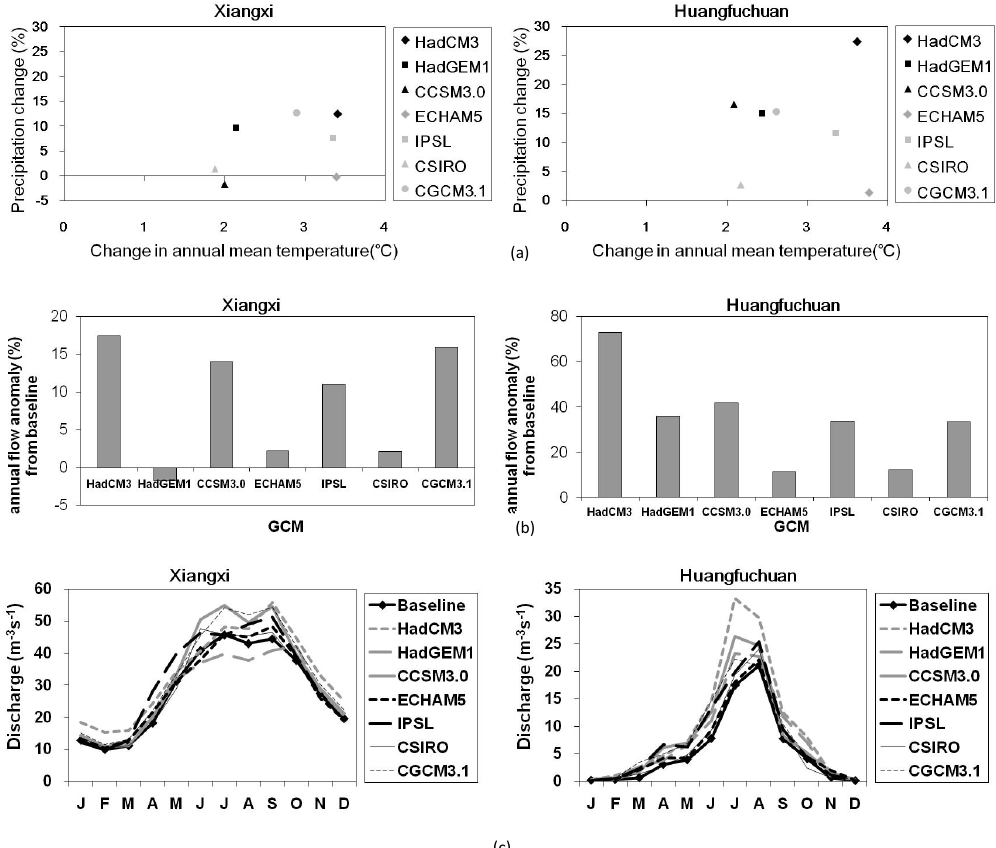
Fig. 5. (a) Projected changes in annual mean temperature ( ◦ ) and annual precipitation (%), (b) annual and (c) monthly discharge under Fig.5. (a) Projected changes in annual mean temperature ( ℃ ) and annual precipitation (%), (b) annual and (c) monthly discharge under SRES A1B across 7 GCMs SRES A1B across 7